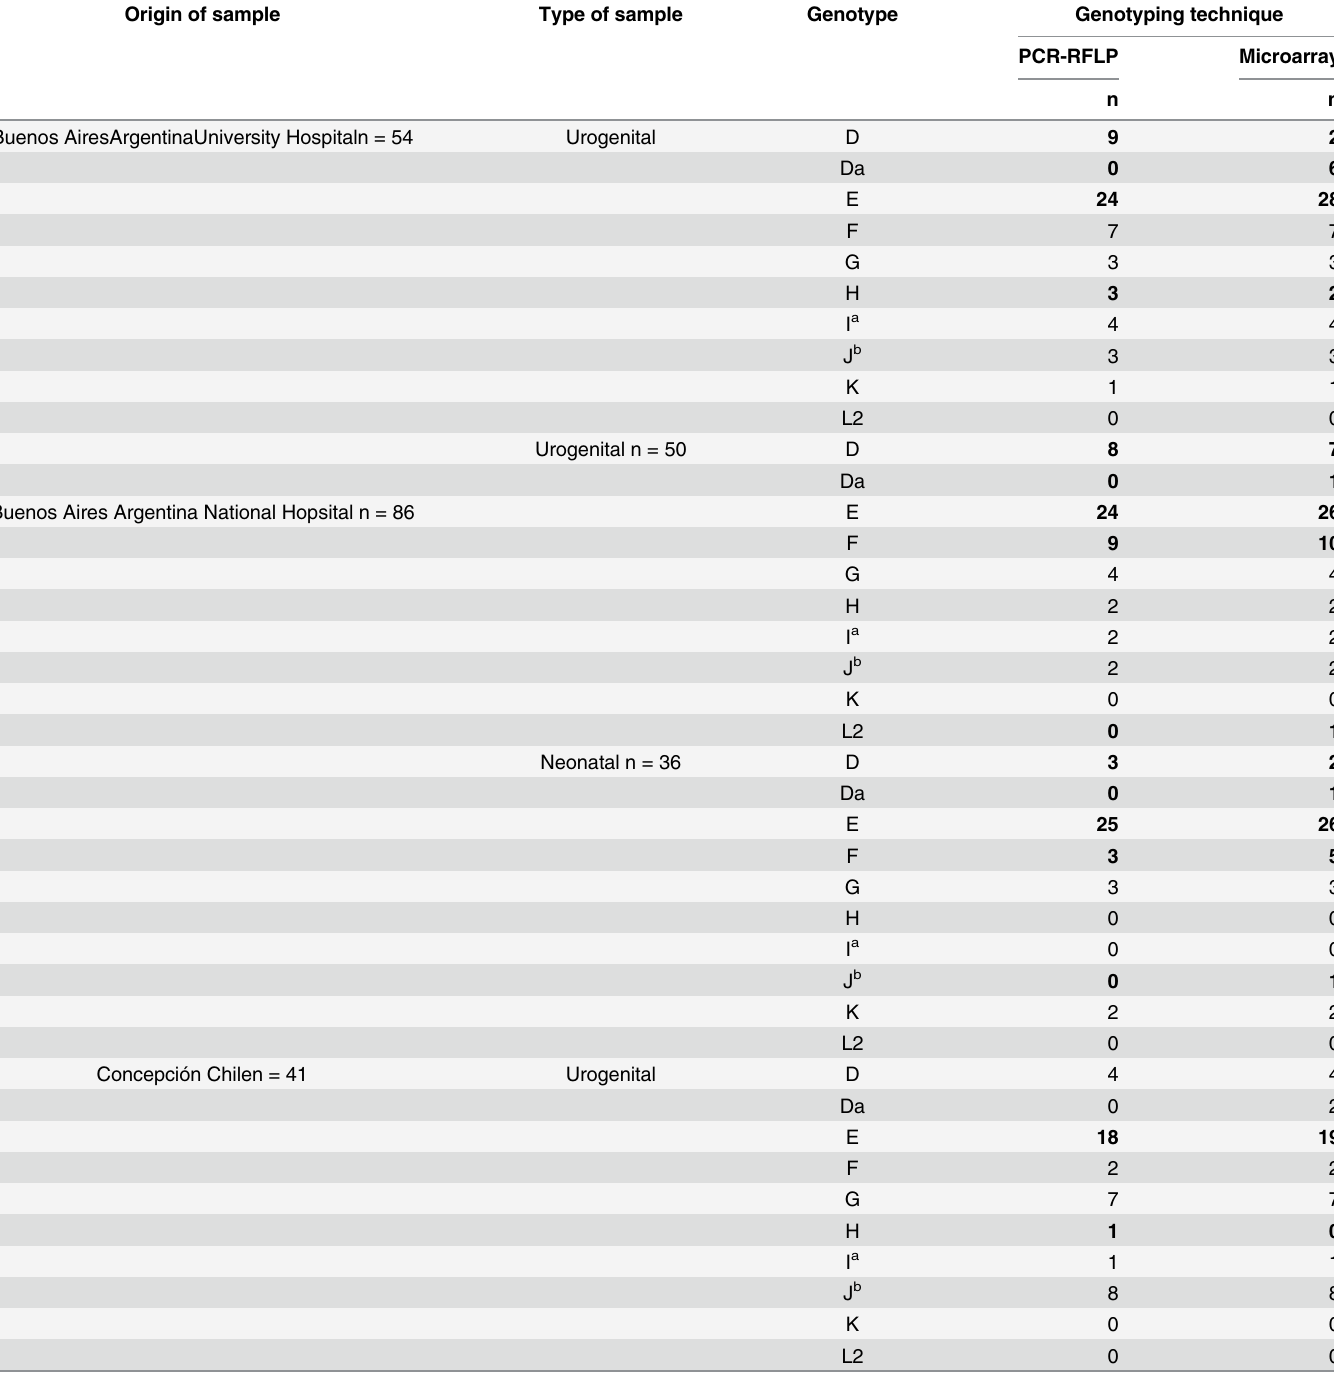
Table 3. Distribution of C . trachomatis genotypes according to type of